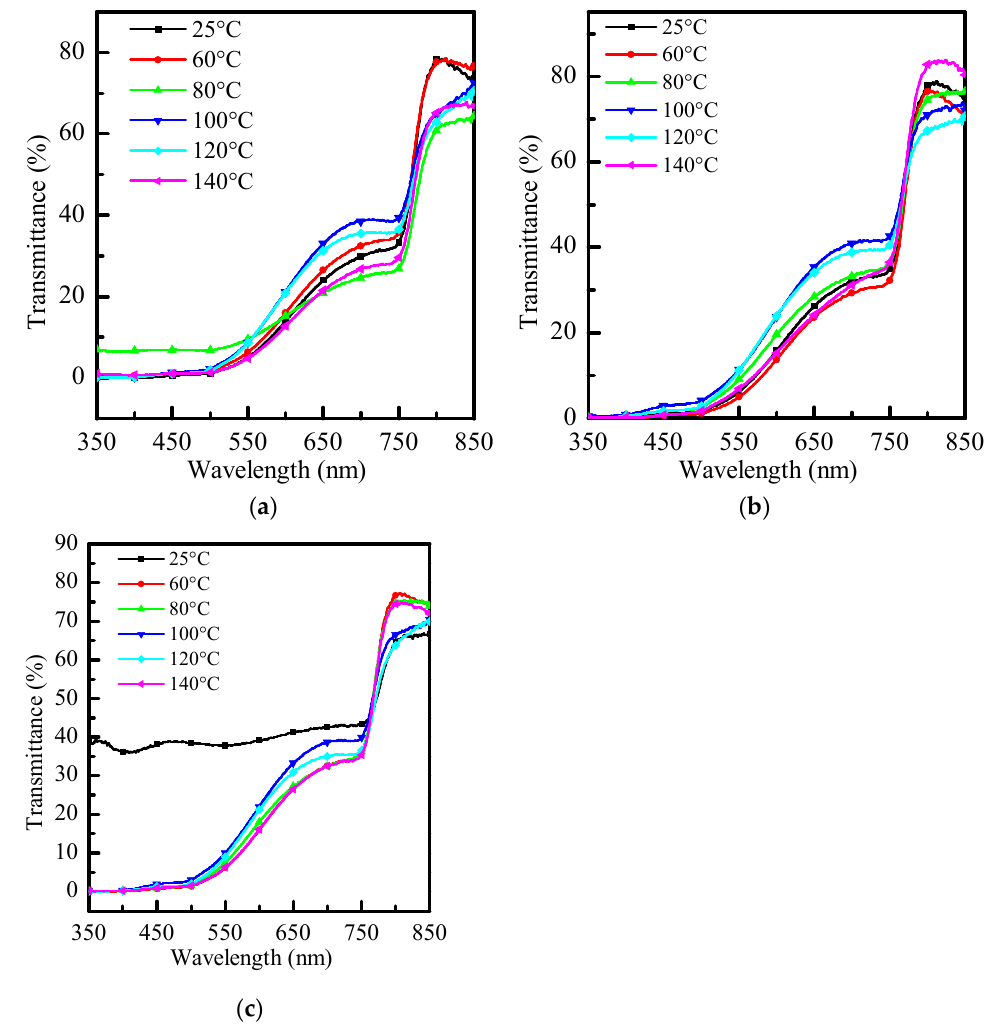
Figure 2. Absorption spectra of ( a ) toluene (PhMe), ( b ) chlorobenzene (PhCl), and ( c ) o -dichloroben- zene (ODCB) at different annealing temperatures, respectively.